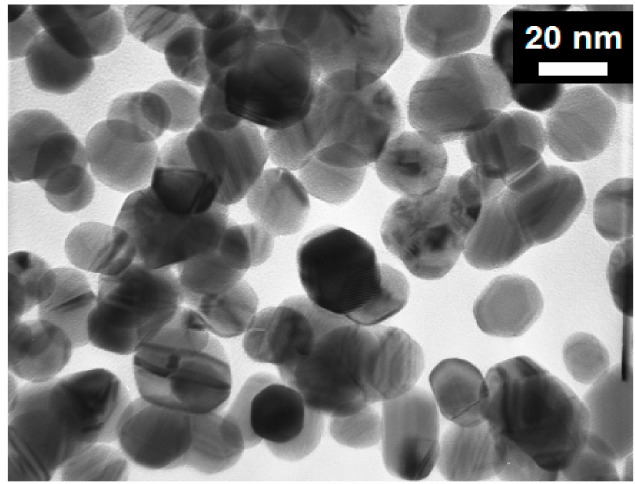
Figure 2. Transmission electron microscopy (TEM) image of silver